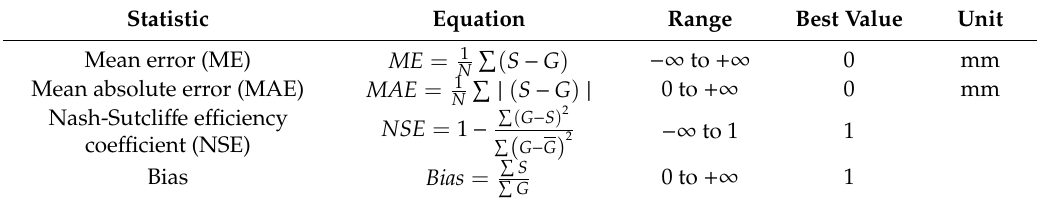
Table 3. Statistical measures of performance, used for analysis based on continuous metrics, where: G = the rainfall total at a reference gauging station, G = the mean observed rainfall total at a reference gauging station, S = rainfall total for a satellite product, and N = the number of data pairs compared. Statistic Equation